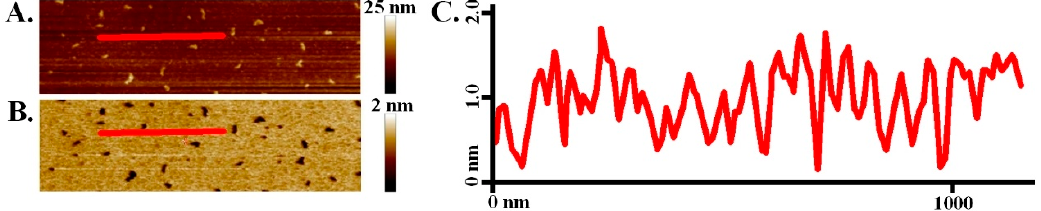
Figure 4. Poly(APTAC)+SPIONs brushes AFM images: topography ( A .) and indentation ( B .) with corresponding indentation image cross-section ( C .).